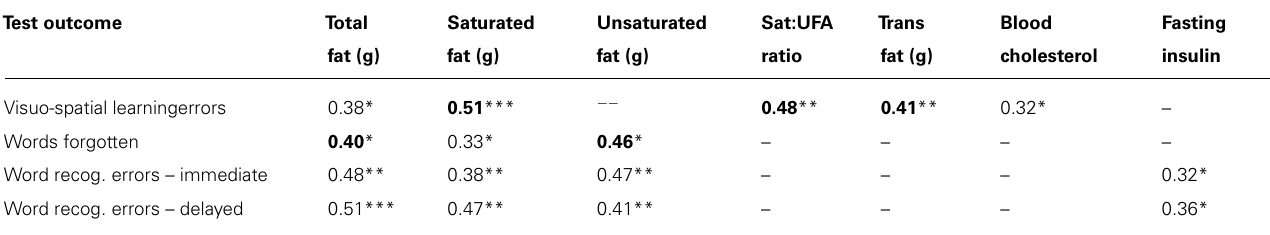
Table 5 | Partial correlations a between measures of memory function and dietary fat intakes or physiological indices in 25- to 45-year-old women ( n = 38). Test